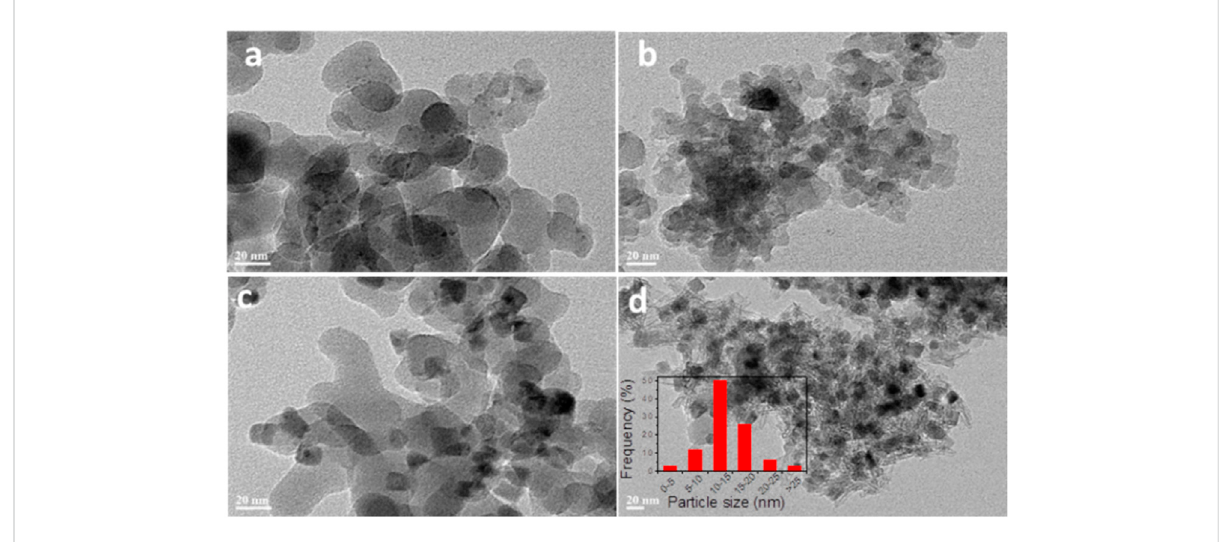
FIGURE 2 TypicalTEMimagesofCu/SiO 2 catalystspreparedbydifferentmethodafterreduction. (A) Cu/SiO 2 -EI, (B) Cu/SiO 2 -DP, (C) Cu/SiO 2 -HT-6.5, (D) Cu/SiO 2